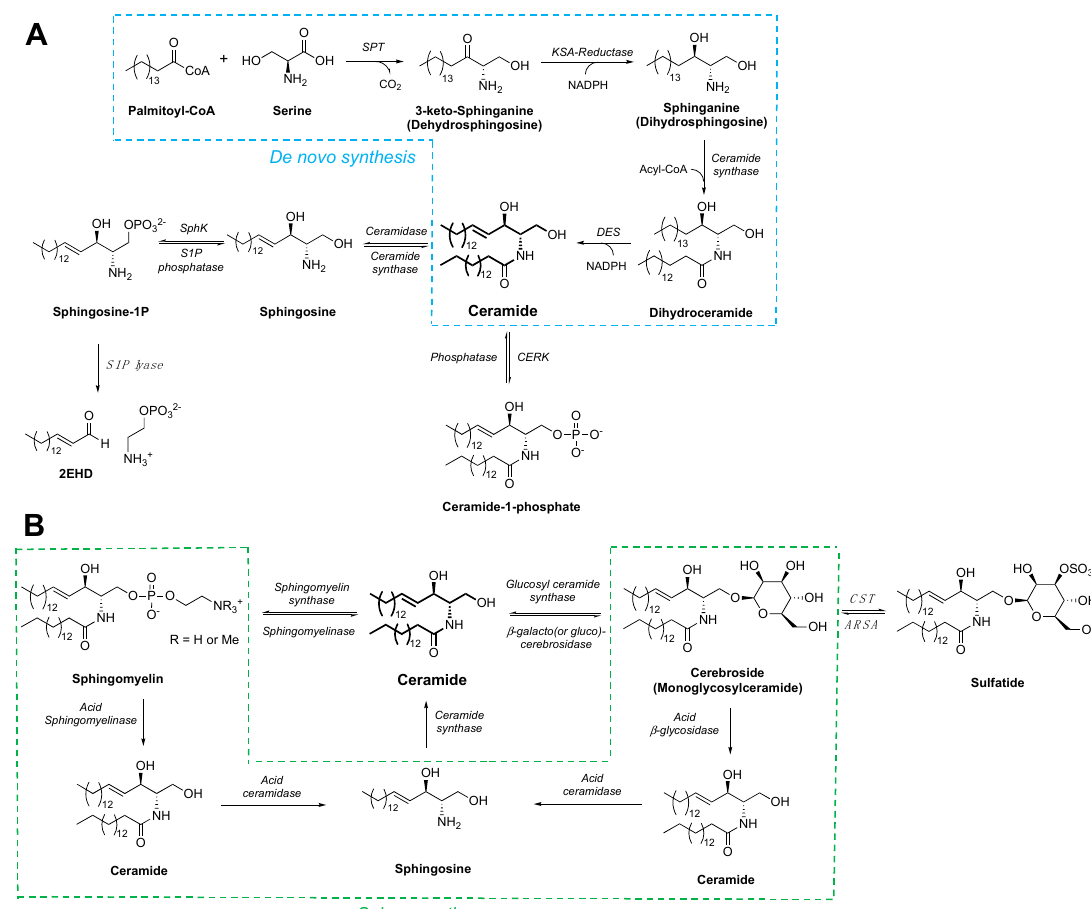
Figure 1. Synthesis and metabolism of sphingolipids and ceramides. ( A ) De novo synthesis of sphingolipids begins with the condensation of serine and palmitate to 3-ketosphinganine, which is reduced to sphinganine. Ceramide synthase catalyzes the N-acylation of sphinganine to dihydroceramide, which forms ceramide after desaturation. SPT: serine palmitoyltransferase; KSA-reductase: 3-ketosphinganine reductase; DES: dihydroceramide desaturase; SphK: sphingosine kinase; S1P phosphatase: sphingosine 1-phosphate phosphatase; 2EHD: (2 E )-hexadecenal; CERK: